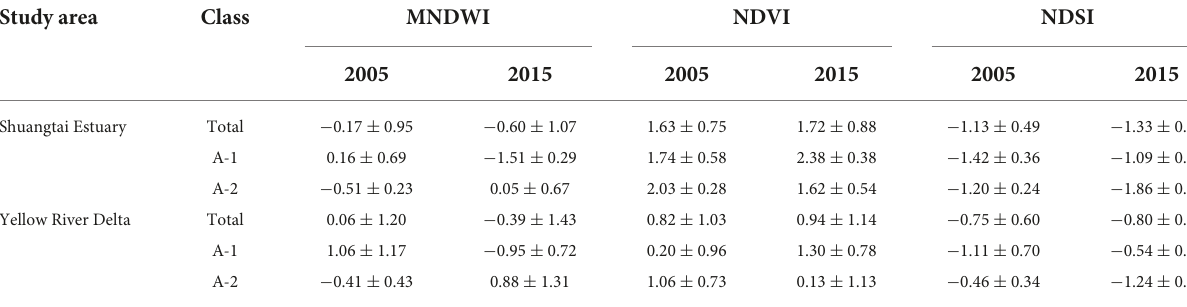
TABLE 7 The spatial accumulation of ecological indicators in the changing